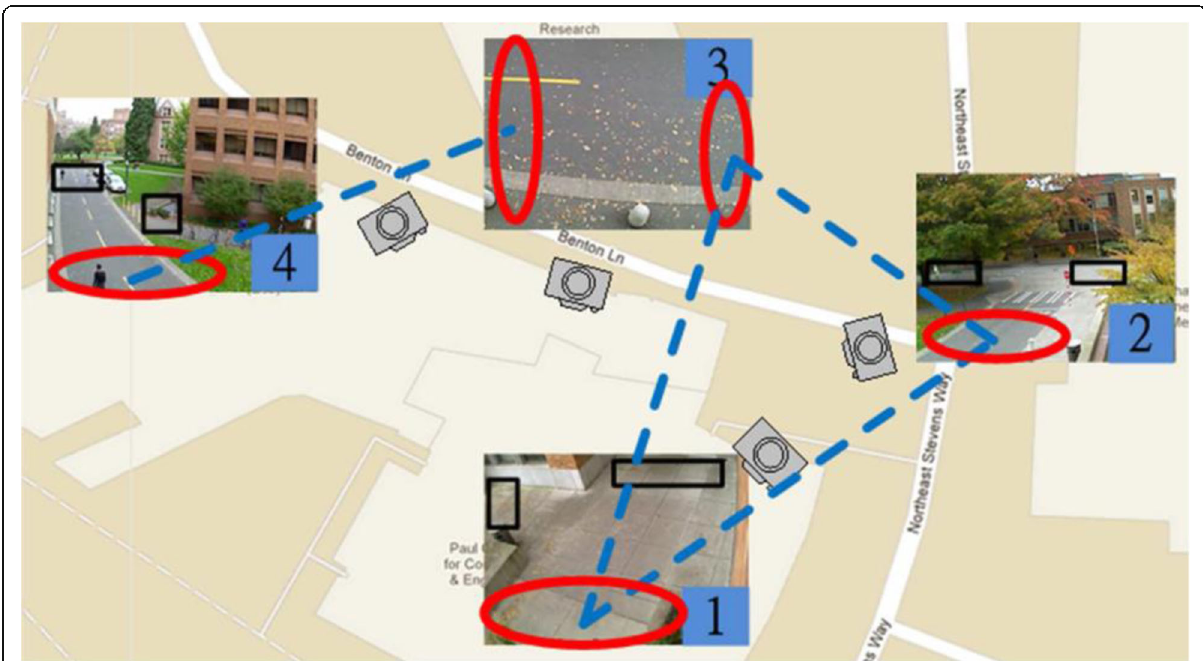
Fig. 13 Camera topology. Blue broken lines denote four links, and red ellipses denote the corresponding entry or exit zones. Black rectangles are the other entry or exit zones that have no any link between both cameras